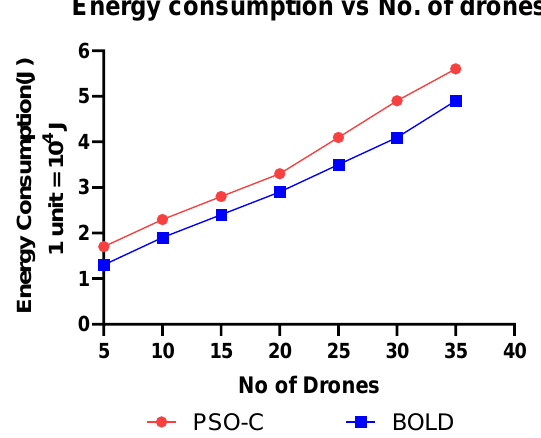
BOLD Figure 13. Energy consumption vs. the number of drones. Figure 13. Energy consumption vs. the number of drones. Table 5. Energy consumption (J) vs the number of drones (1 unit = 10 4 Joules).